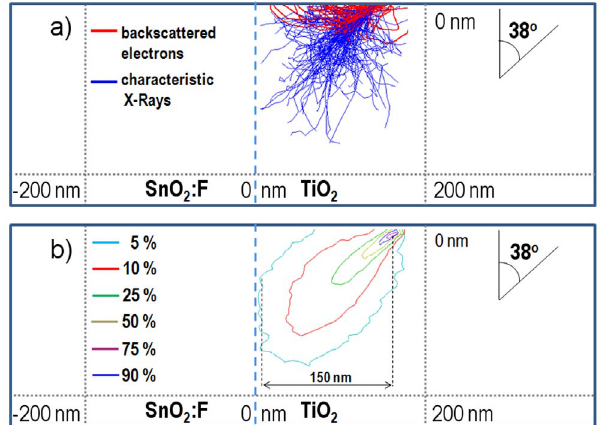
Figure 8. Simulations of a) electrons trajectories and b) X-Ray emission region in the EDX analysis. Incident electron plume determined to be approx. 150 nm for an accelerating voltage of 10 keV that was used